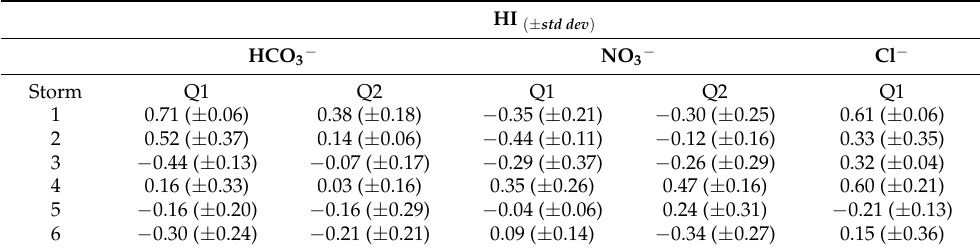
Table 5. Hysteresis index (HI) of HCO 3 − , NO 3 − and Cl − for the rainstorms in the locations Q1 and Q2 along the Kanawha